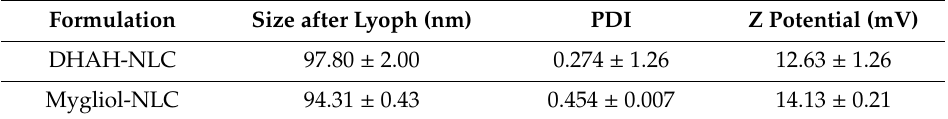
Table 3. Characterization of the final nanoformulations used for cell culture tests. ( n = 2 independent